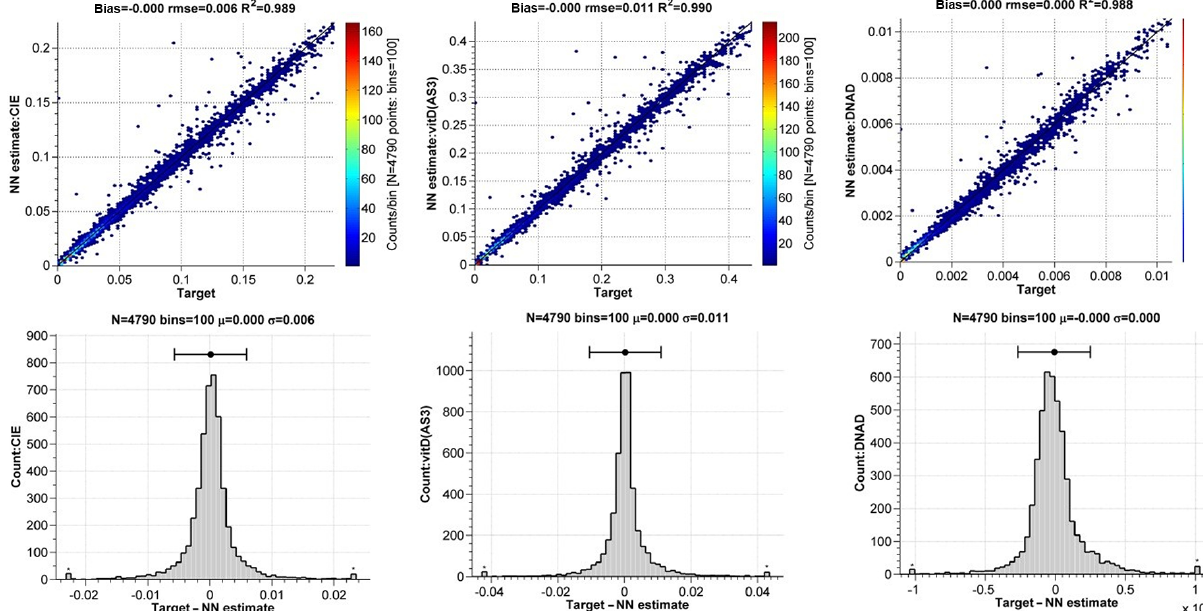
Figure 4. NN validation. Upper panels: regression of the NILU103 NN estimates on the coincident Brewer-derived erythemal UV dose (CIE) (left), vitamin D (center), and DNA-damage dose (right). Lower panels: histograms of the difference between NN estimates and the Brewer-derived quantities. The mean ( µ ) and standard deviation ( σ ) are